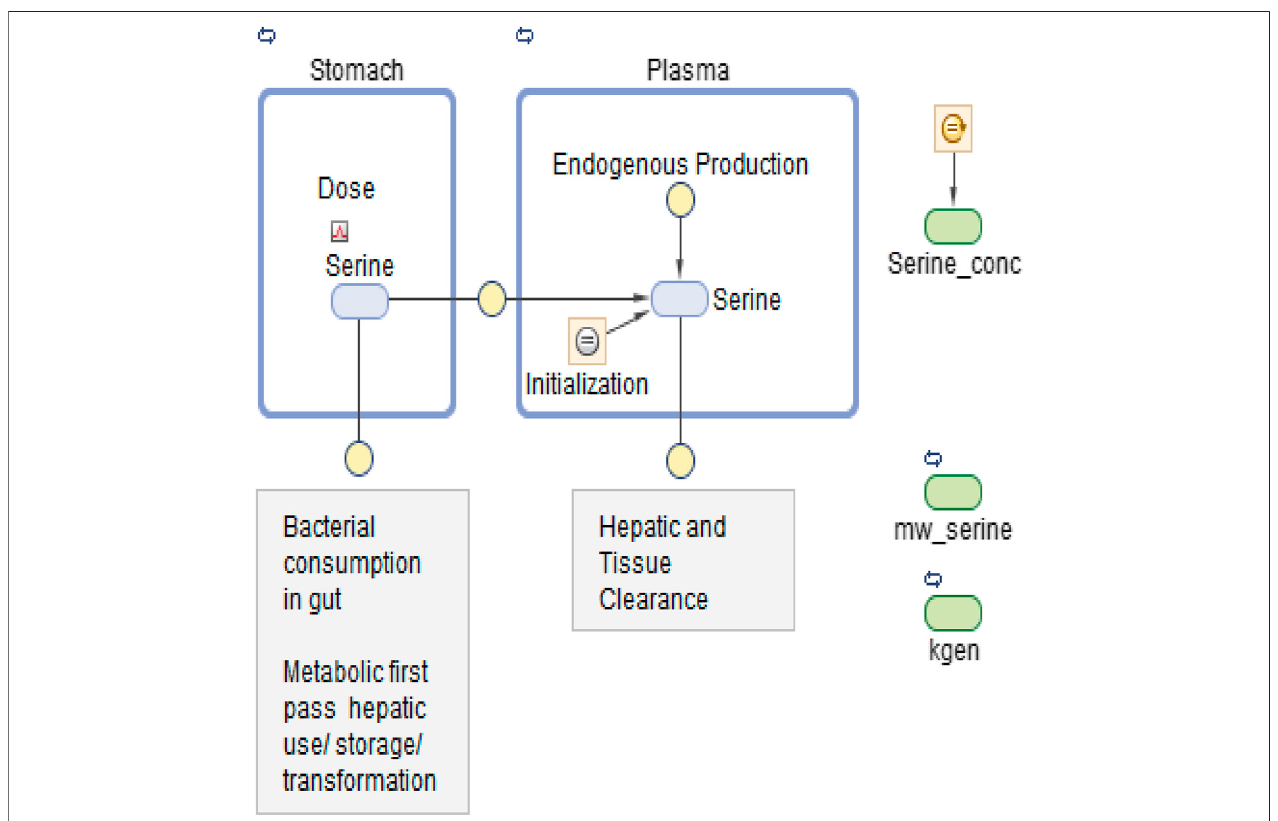
FIGURE 3 | Graphical model representation from SimBiology(R).